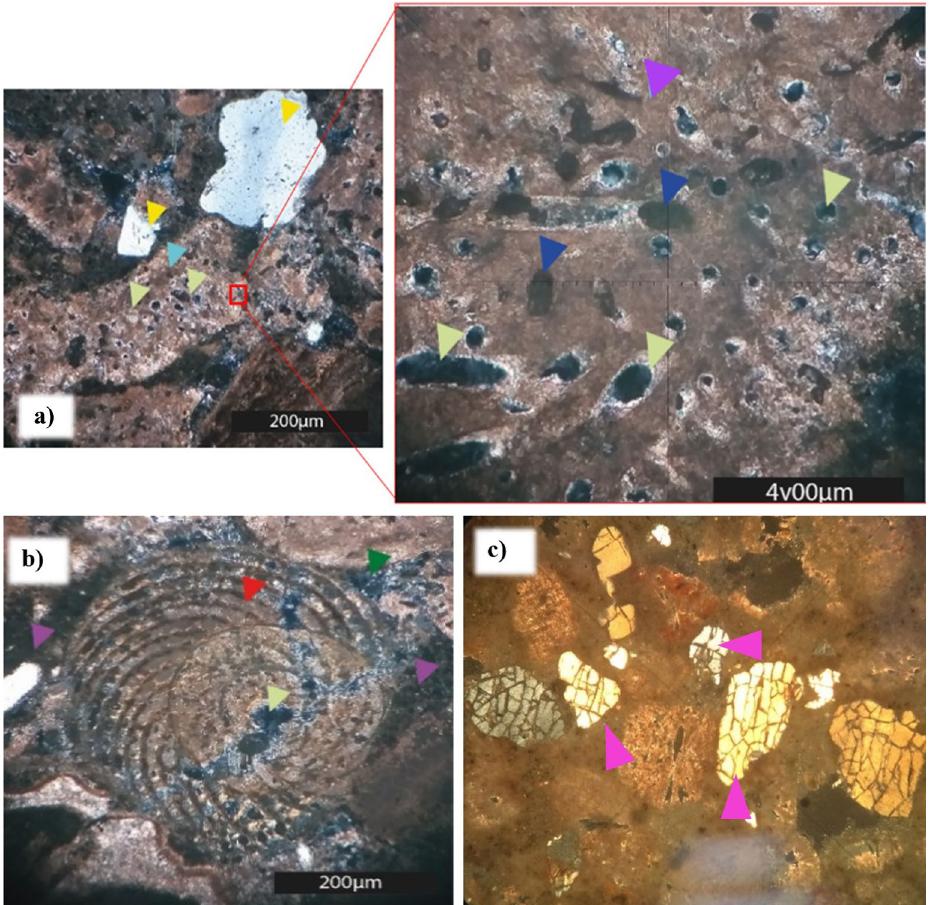
Figure 15. Images (obtained using a petrographic microscope, Nikon Eclipse POL) of the petrographic slide of the cement sample after degradation with longer exposure to acidic fluid, emphasizing the increase in intraparticle porosity. ( a ) Micrograph at parallel nicols (light green arrow—intra-particle porosity; red arrow— carbonate grain; yellow arrow—quartz grain). Enlarged image to more clearly display intra-particle porosity. ( b ) Micrograph of crossed nicols showing calcium carbonate skeletal grain of a gastropod (blue arrow— carbonate skeletal grain; green arrow—porosity; red arrow—rounded grain of quartz; lilac arrow—cement). ( c ) Micrograph at parallel nicols showing changes in the structure of quartz grains after degradation (pink